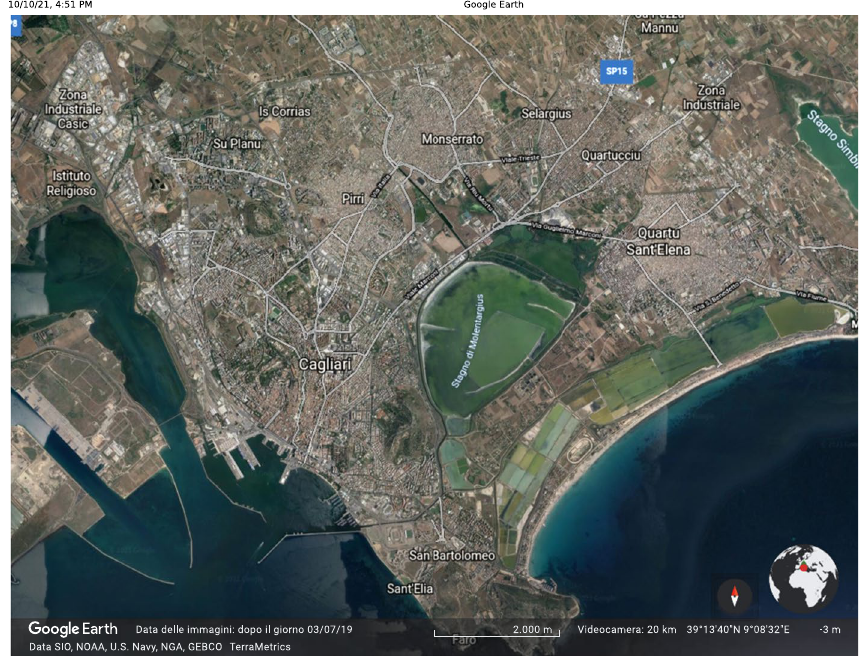
Fig. 18 Cagliari metropolitan area; image produced by Google